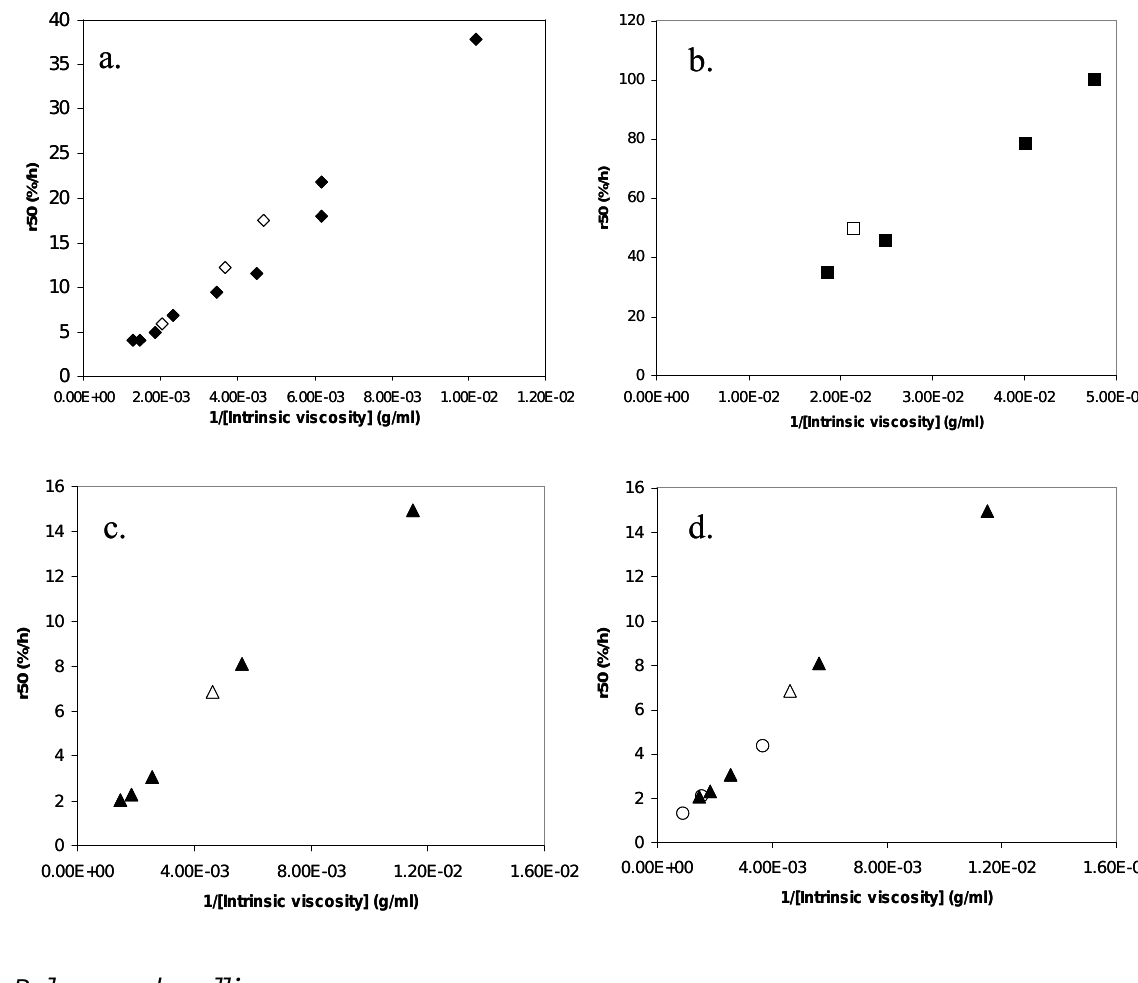
Figure 6. The release rate (r ) plotted against the inverse of the intrinsic viscosity of the 50 polymer in the tablet for: (a) PEO, (b) dextran, (c) HPMC 60SH and (d) HPMC 90SH (triangles) together with HPMC 60SH (circles). The filled symbols represent the mixed samples and the unfilled symbols the nonmixed